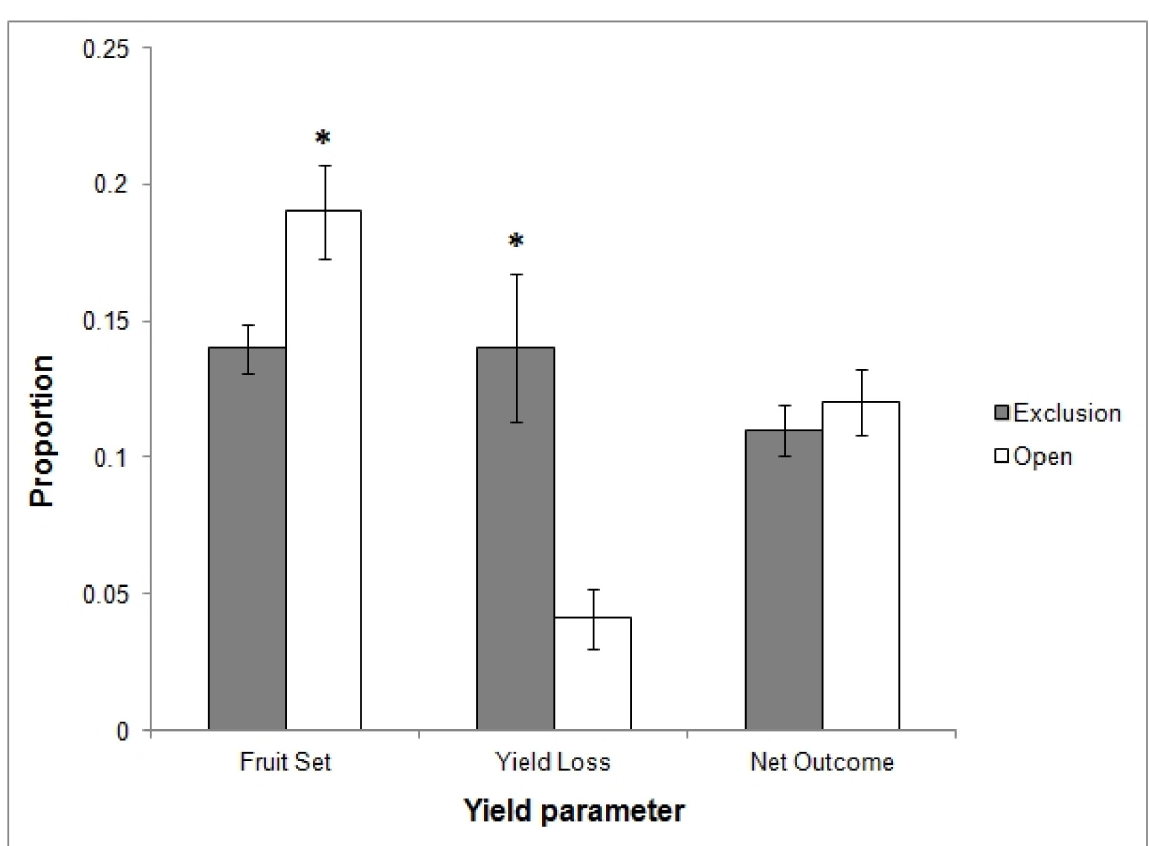
Fig 1. Mean yield parameters ( ± SE) for open and exclusion branch treatments on each tree (n = 60). Fruit Set = number of initial fruitlets as a proportion of the number of blossoms; Yield Loss = number of damaged fruit at harvest as a proportion of the total number of fruit; Net outcome = the number of undamaged fruit as a proportion of the number of initial blossoms per branch. Asterisks indicate a significant difference between open and exclusion means for the relevant yield parameter (p < 0.05).